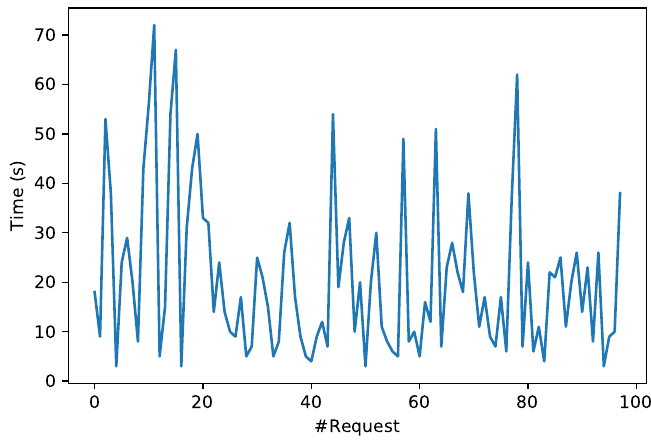
Figure 17. Ropsten testnet time